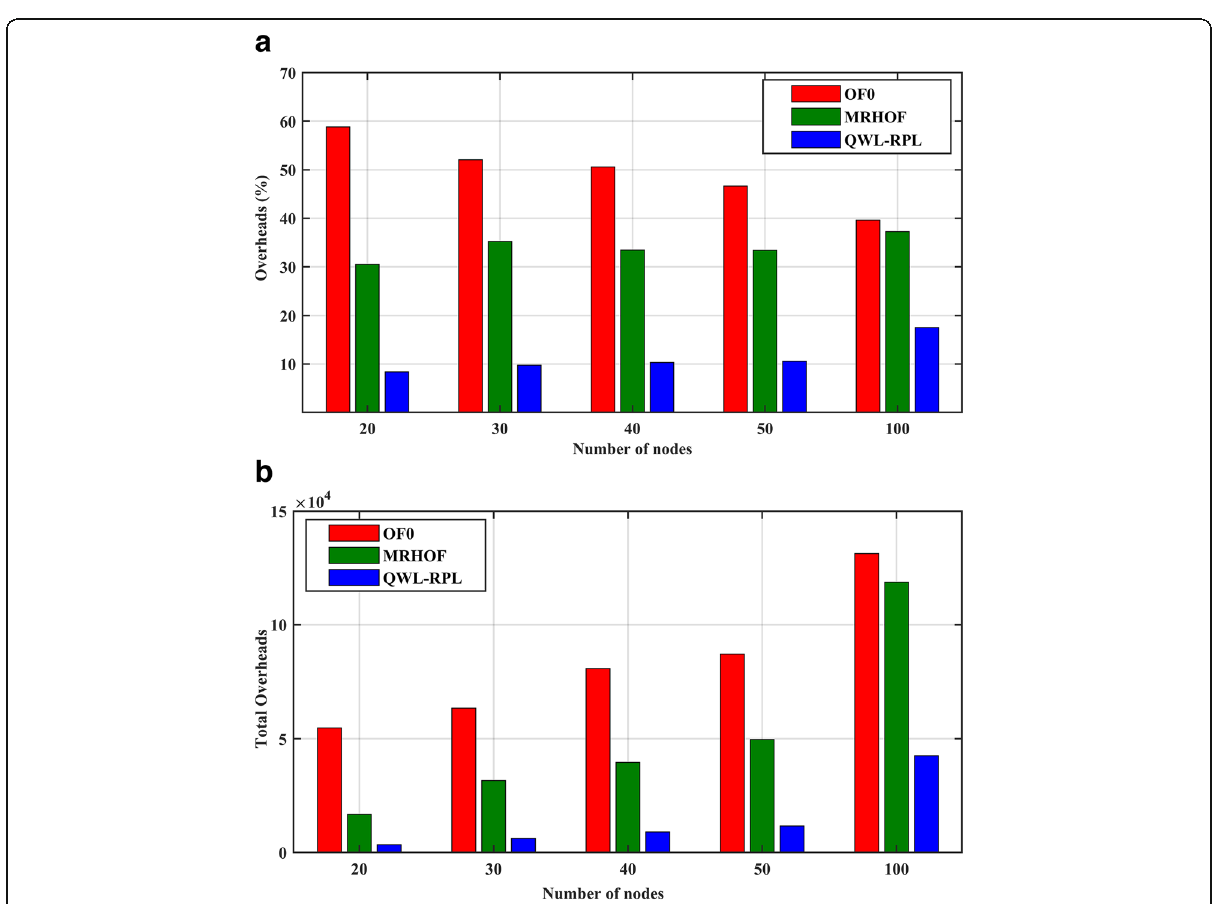
Fig. 14 Simulation analysis for scenario II for the a overheads (%) and b the total number of overheads versus number of